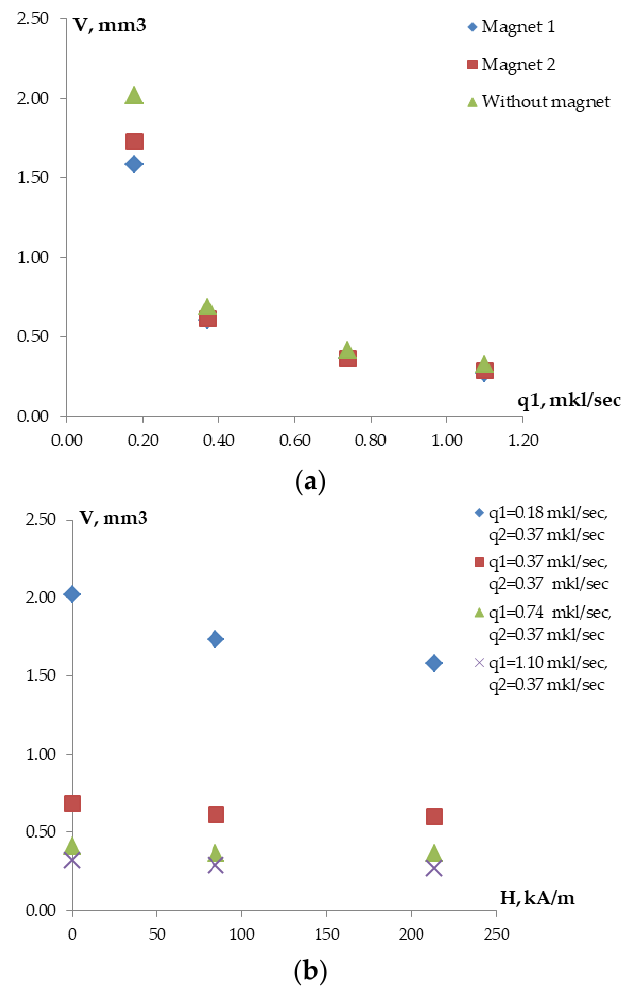
Figure 6. Dependence of the volume of separated droplets in sandwich chip with glass walls (Figure 2b): ( a ) on the flow velocity MF; ( b ) on the magnetic field strength.